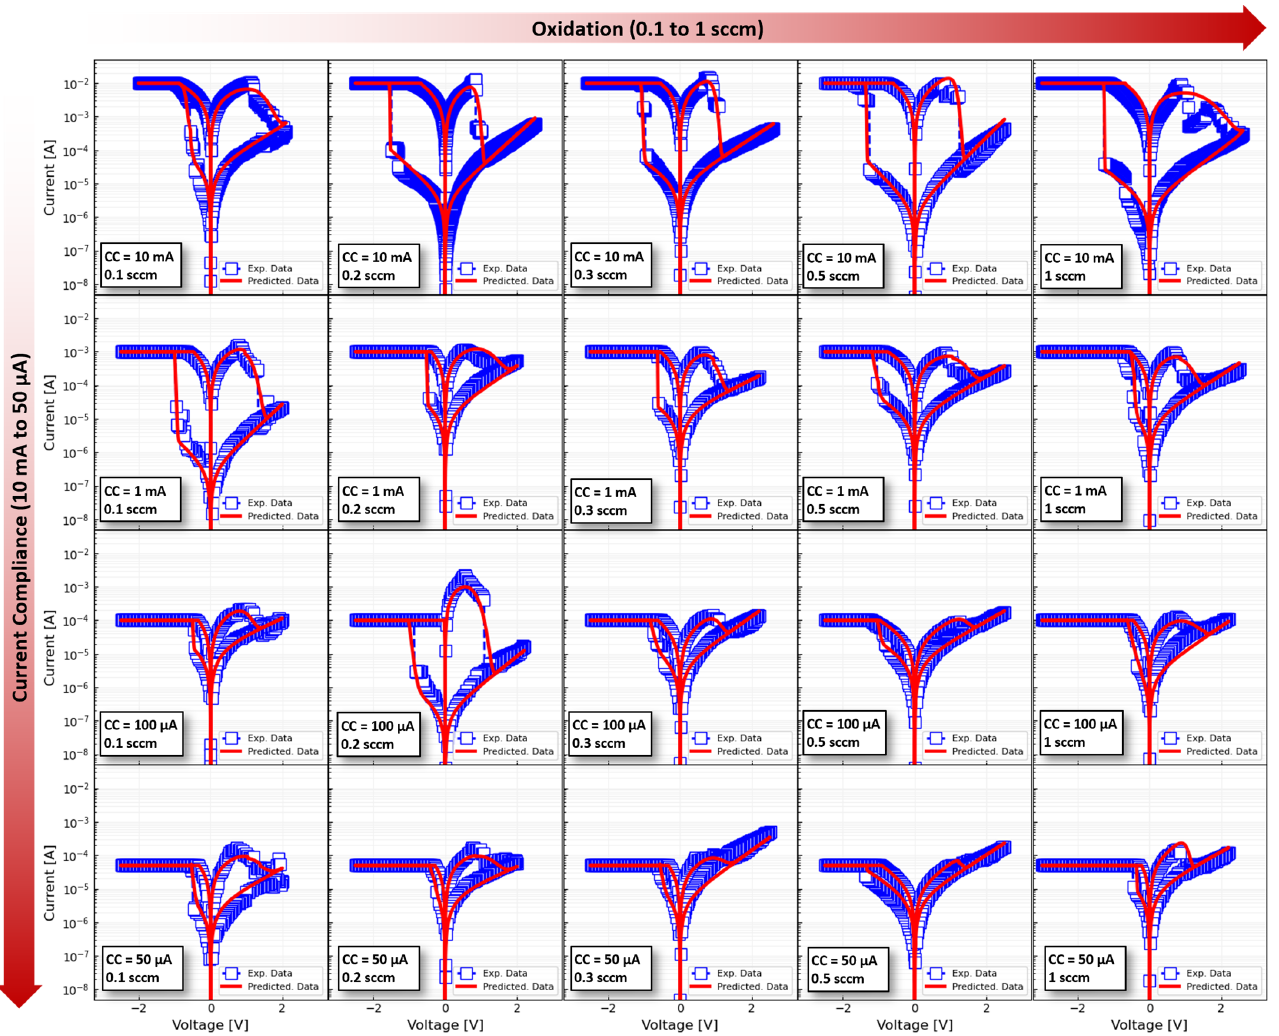
Figure 8. Representative I-V loops for each oxidation-current compliance pair (totaling 20 different combinations). Each column from left to right groups the samples fabricated with the same oxidation condition (0.1, 0.2, 0.3, 0.5, 1 sccm) and each row summarizes the measurements carried out with the same current compliance (50 µ A. 100 µ A, 1 mA, and 10 mA). In each panel, one experimentally measured I-V loop is plotted together with a simulation of the DMM whose parameters were obtained with the trained ANN.